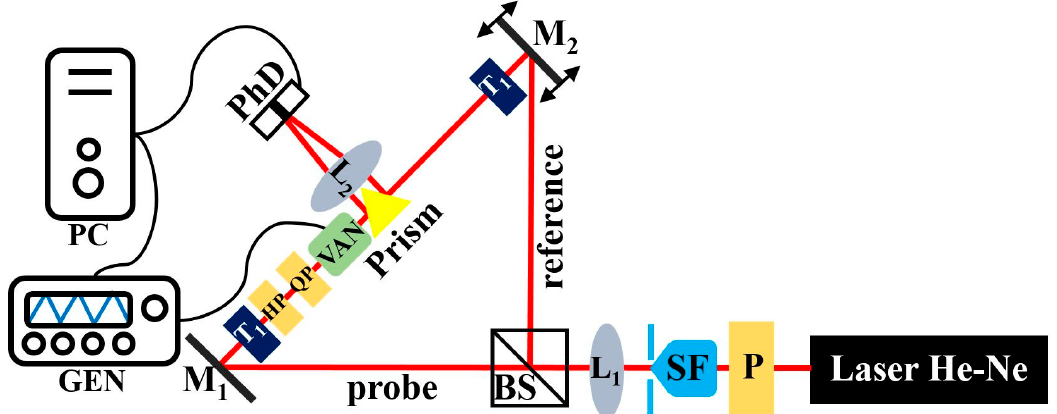
Figure 3. The scheme of the interferometer setup. Light source: He-Ne laser with λ = 633 nm; P - linear polarizer; SF – spatial filter; L 1 , L 2 – lenses, BS – beam splitter; M 1 , M 2 – mirrors; T 1 , T 2 – telescopes, VAN – vertically aligned nematic liquid crystal cell; PhD – photodetector, Gen – generator, HP – half- wave plate, QP – quarter-wave plate. Adapted from [16,17].